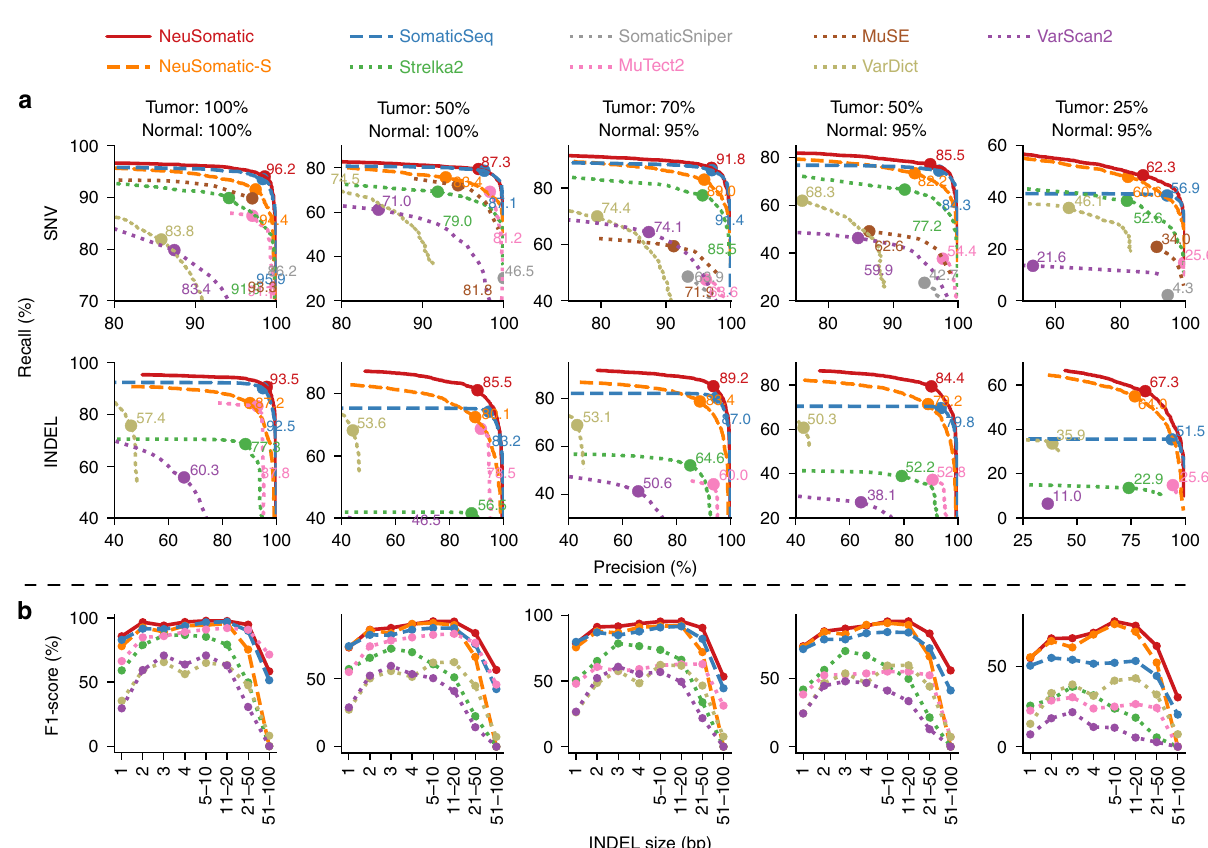
Fig. 3 Performance analysis of the DREAM Stage 3 dataset. In this dataset, fi ve tumor and normal purity scenarios (100% T:100% N, 50% T:100% N, 70% T:95% N, 50% T:95% N, and 25% T:95% N) are used. a Precision-recall analysis: the con fi dence or quality scores are used to derive the precision-recall curves. The highest F1-score achieved by each algorithm is printed on the curve and marked with a solid circle. b Performance analysis of INDEL accuracy (F1-score) for different INDEL